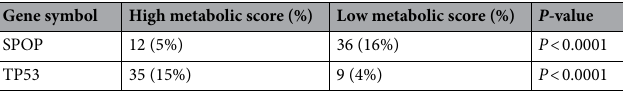
Table 1. Association of metabolic score with somatic variants.